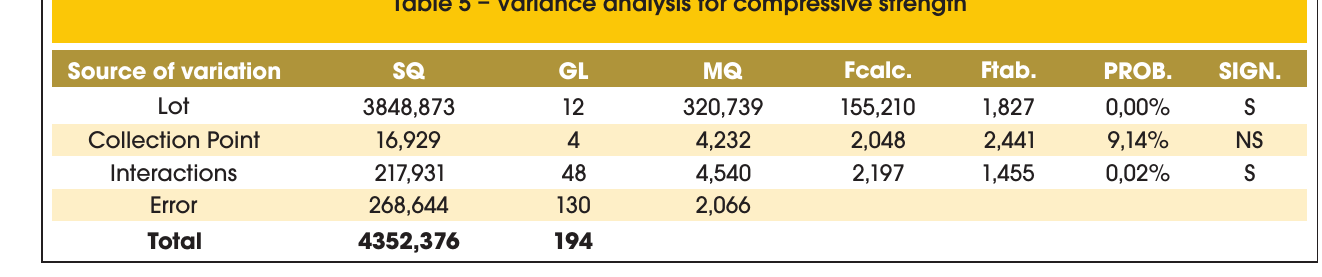
Table 5 – Variance analysis for compressive strength